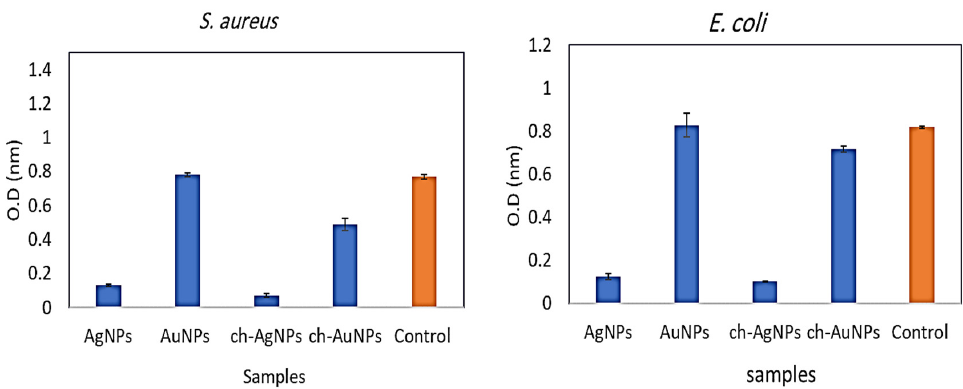
Figure 5. Antibacterial activity of the prepared chitosan–AgNPs and –AuNPs in comparison with biosynthesized nanoparticles.